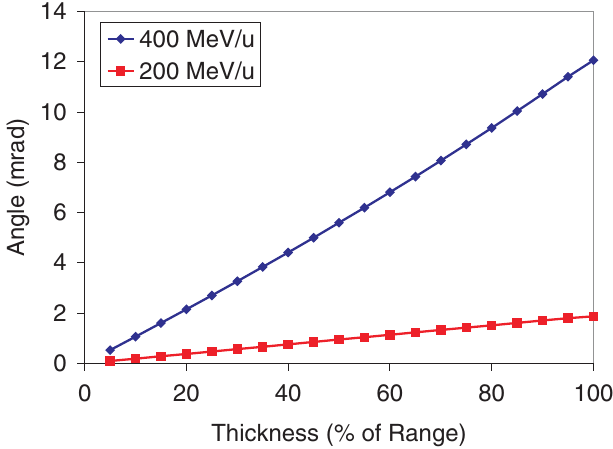
FIG. 7. (Color) The main linear effect of the wedges after shaping them using the optimal angle is the increased magnifi- cation. The plot shows the magnification for a 132 Sn beam at two different energies as a function of wedge